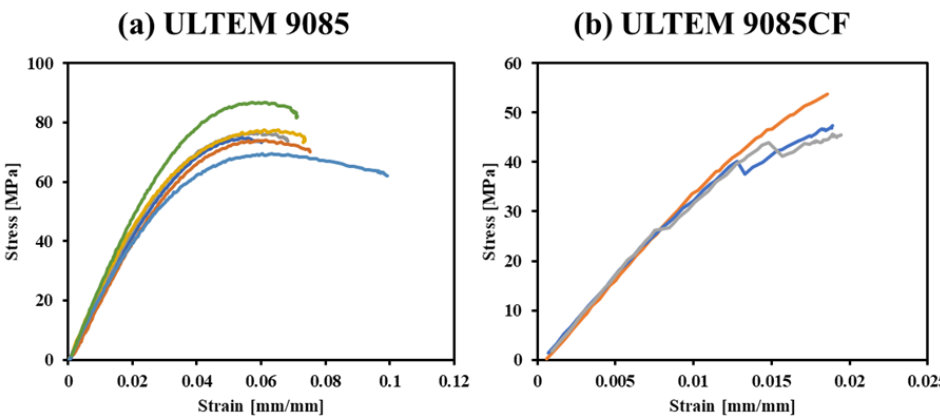
Figure 10. Tensile testing data for all single-material ( a ) ULTEM 9085 and ( b ) ULTEM 9085CF spec-